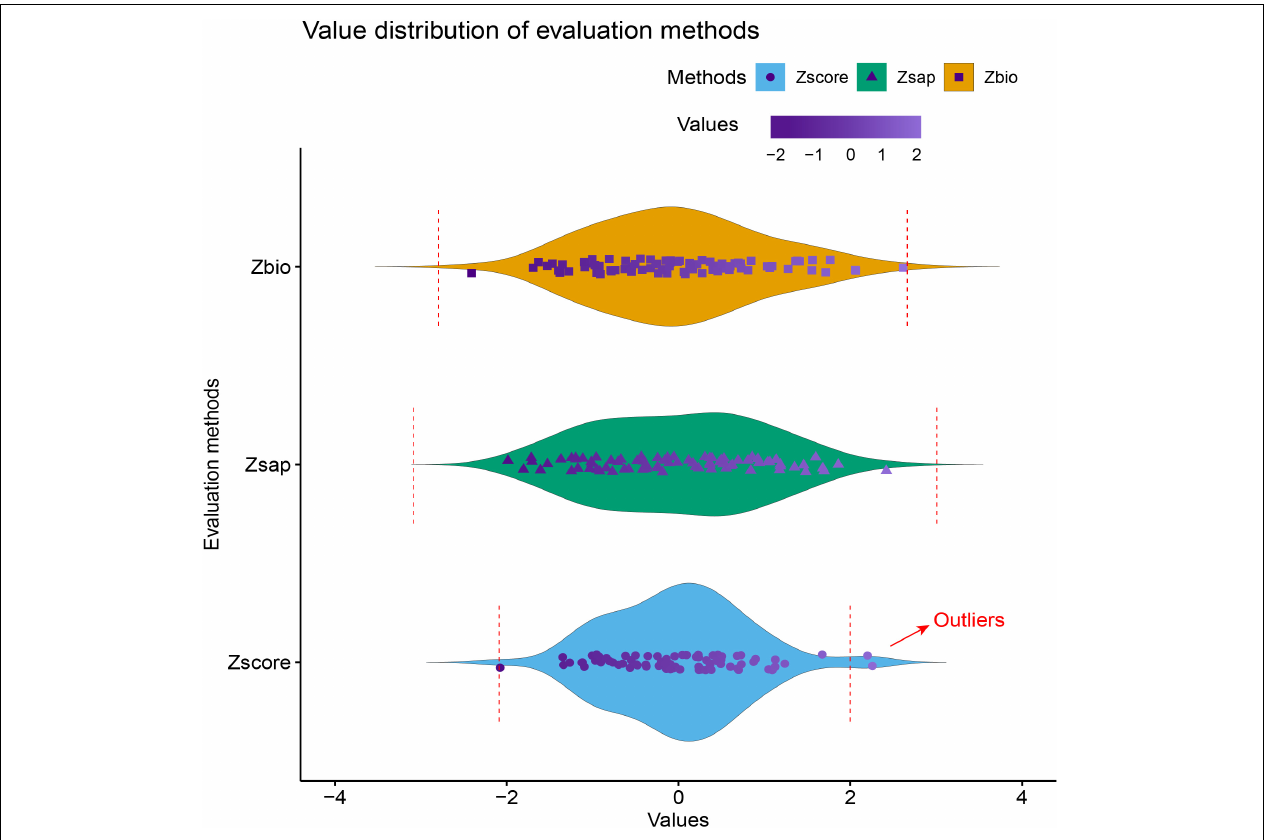
FIGURE 2 | Distribution of three evaluation